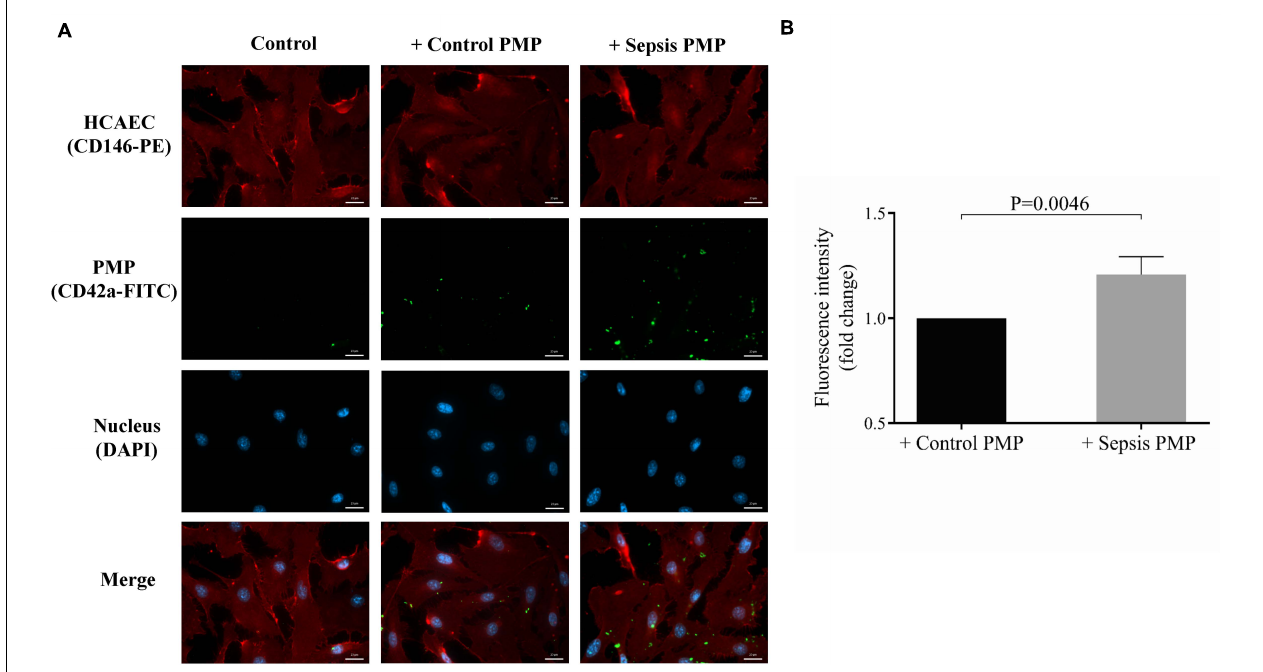
FIGURE 3 | Immunostaining of the internalization of sepsis PMP by endothelial cells. Endothelial cells (HCAECs) were incubated with control and sepsis isolated platelet-derived microparticle (PMP) samples for 24 h at 37 ◦ C and HCAECs were then stained with anti-CD146-PE antibody (red) and PMPs were labeled with anti-CD42a-FITC antibody (green). The uptake of PMPs was investigated by fluorescence microscopy (A) . Blue: cell nuclei. Significantly higher fold change in fluorescence intensity ( P = 0.0046) was detected in the cytosol of endothelial cells with septic PMPs compared to HCAECs with control PMPs (B) . Scale bar: 20 µ m. Results are expressed as median with interquartile range ( n = 5–6 cells/condition). Mann-Whitney U -test was performed for